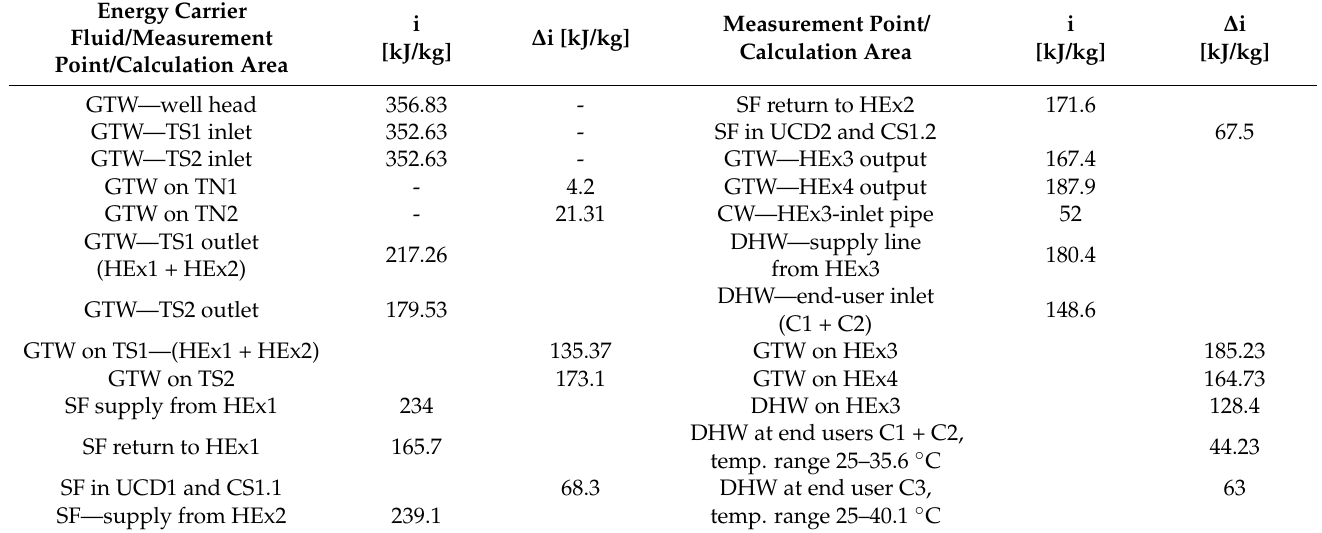
Table 6. Enthalpy values of energy carrier fluids inside TS at hourly